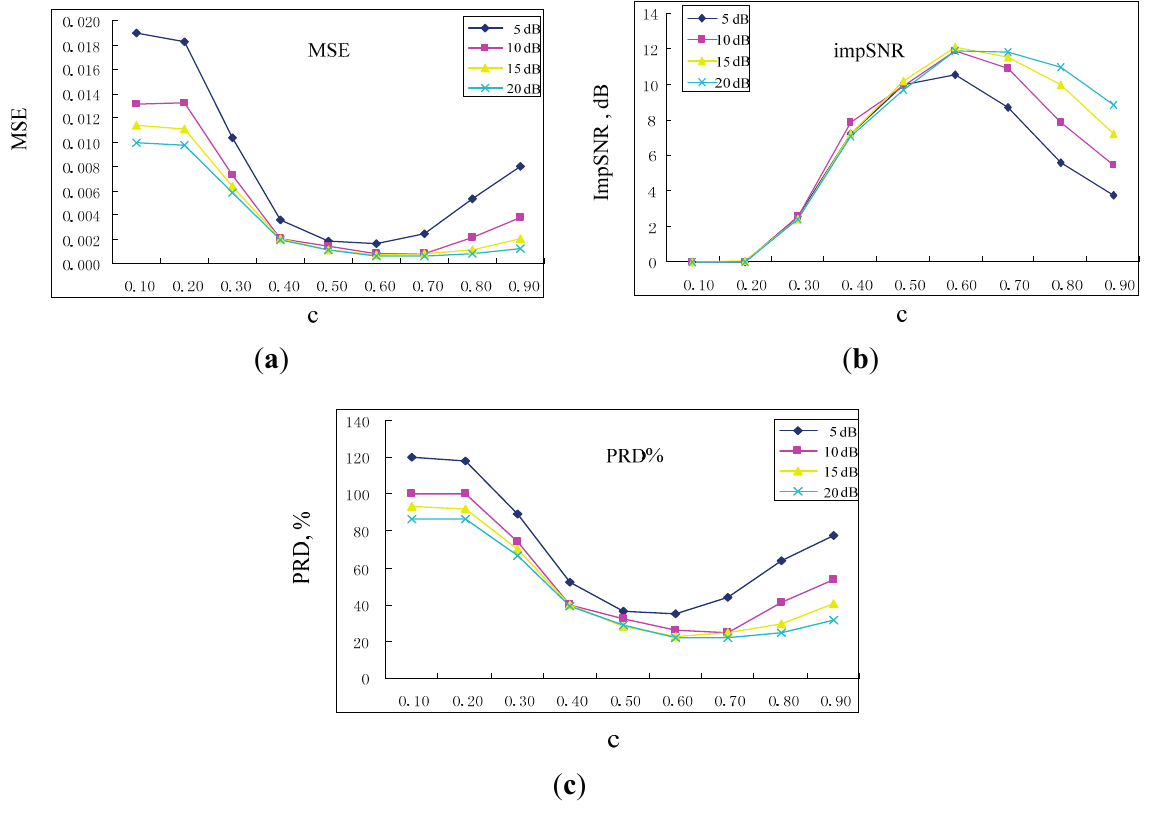
Figure 3. MSE ( a ), impSNR ( b ) and PRD% (percent distortion) ( c ) versus c , when separately adding 5 dB, 10 dB, 15 dB and 20 dB white Gaussian noise